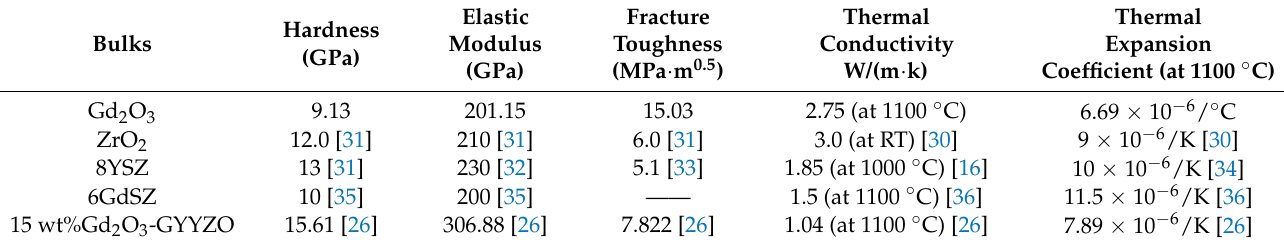
Table 8. Properties of Gd 2 O 3 and co-doped zirconia ceramics used in